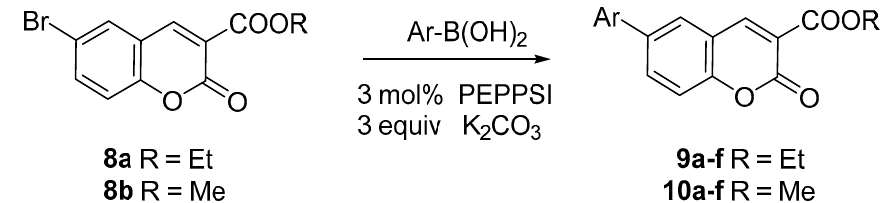
Table 4. Parameters, reagents, and products of palladium-catalyzed arylation of 6-bromocoumarin- 3-carboxylates 8a,b